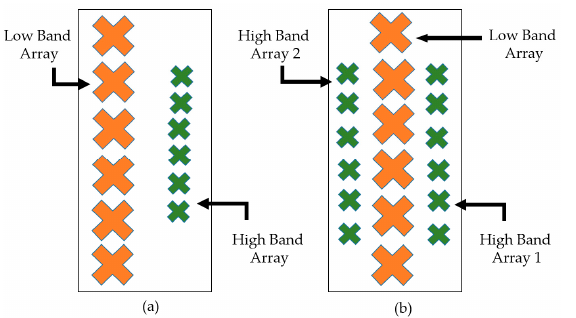
Figure 3. ( a ) Multiband antenna with physically separated arrays; ( b ) multiband antenna with interspersed arrays. interspersed